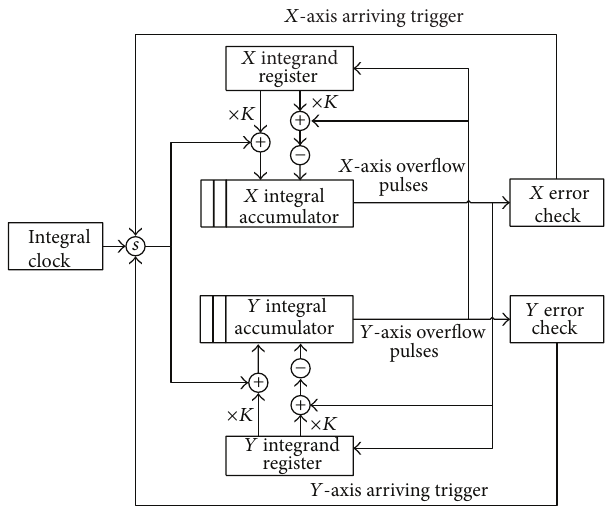
Figure 12: Logic structure of improved DDA arc